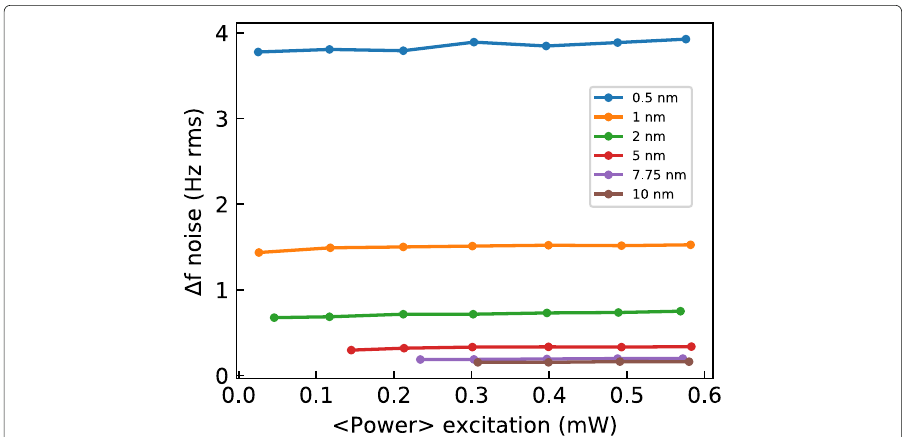
Fig. 9 Frequency shift noise as a function of average optical power of the excitation laser at varying oscillation amplitudes. The frequency shift noise was measured as the root mean square (RMS) of the frequency shift from the lock-in amplifier. The lines are a guide to the